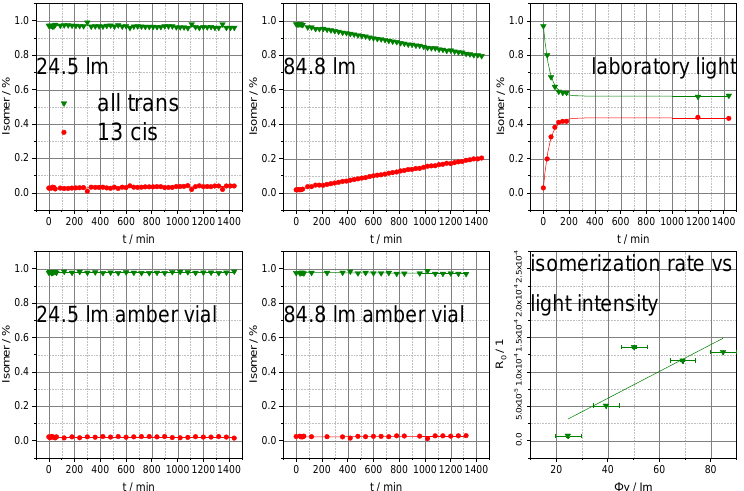
Figure 4. Isomer profiles of retinol at various light intensities and in two different vials, measured at various time points. Additionally, the isomerization rate as a function of light intensity is displayed (error bars represent deviations in light intensity of the LED and isomerization rate).